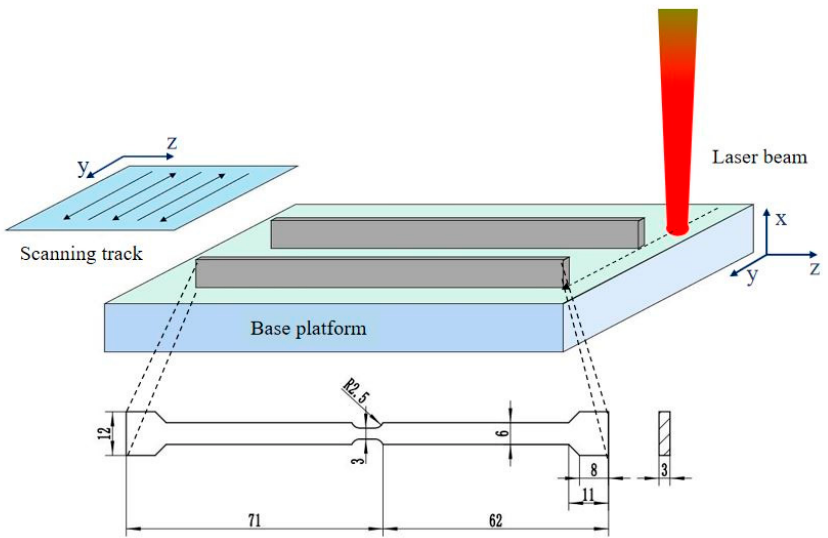
Figure 1. The detailed preparation process and dimensions of Invar 36 alloy specimens.